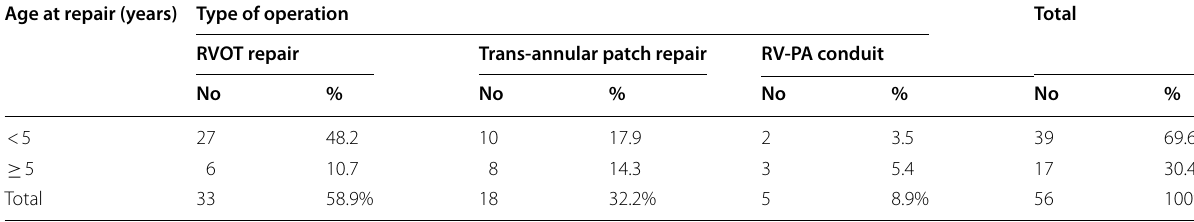
Table 2 Distribution of the included 56 rTOF patients according to the type of operation done and age at repair Age at repair (years) Type of operation